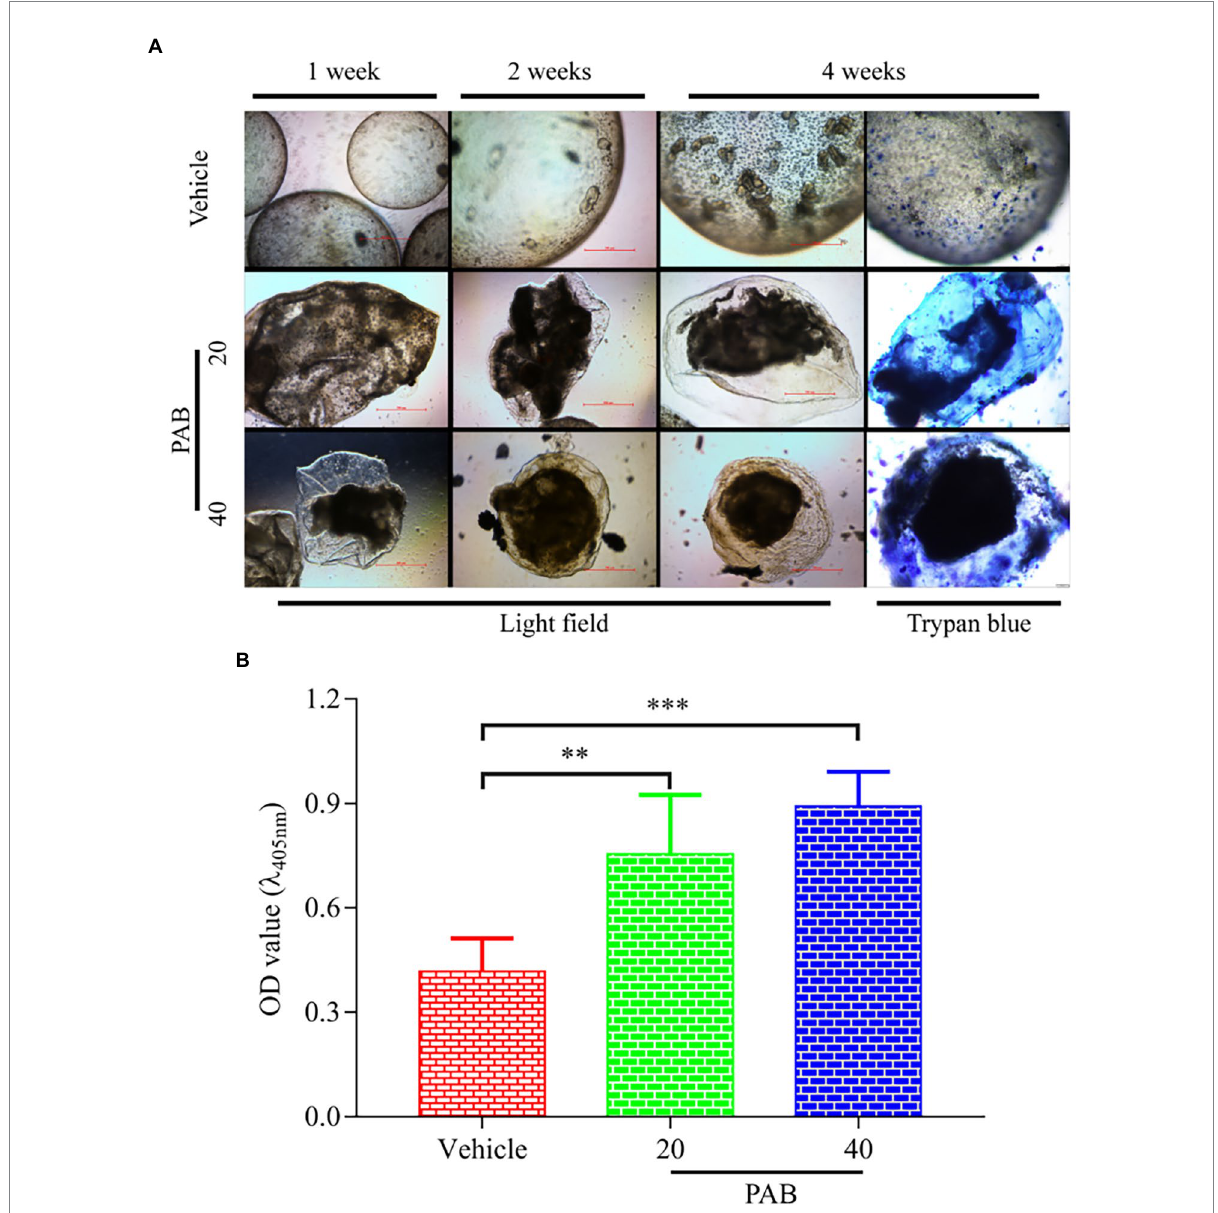
FIGURE 3 Viability changes of E. multilocularis microcysts after treated with PAB in vitro . (A) Microcysts exposed to 20 and 40 μ g/ml PAB for 4 weeks showed ultrastructural damage, such as detachment of the germinal layer from the laminated layer, however the typical germinal layer (GL) (week 1) producing solid protrusions (SP) (week 2), present of daughter PSC (week 4) in the vehicle group. Images were measured by light microscopy at weeks 1, 2 and 4 without any staining; and at week 4 with trypan blue staining. (B) ALP levels in the culture supernatants of E. multilocularis microcysts after treatment with 20 and 40 μ g/ml PAB for 1 week, as measured by chemiluminescence method. All data were assessed using One- way ANOVA with multiple comparisons. The independent experiments were processed in